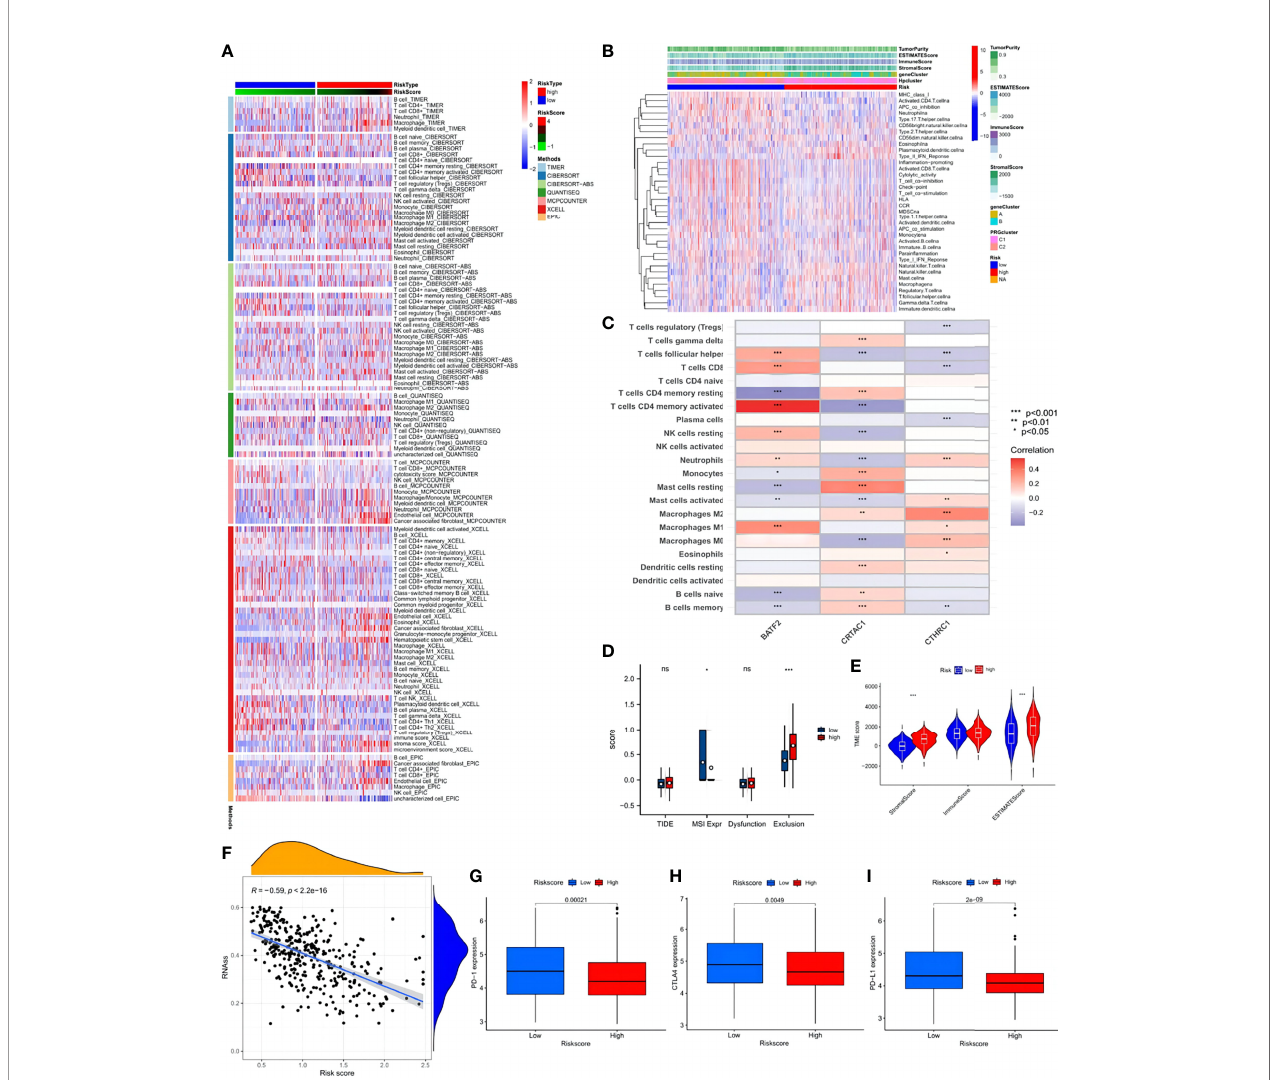
FIGURE 9 | Immune annotation and correlation between HP infection and anti-PD-1/L1, anti-CTLA-4 immunotherapy. (A) Immune cell-in fi ltrating characteristics of high- and low-risk groups and their correlation with risk signature. (B) Relations between tumor purity, ESTIMATE score, immune score, stromal score, and different STAD phenotypes. (C) Correlation between the abundance of immune cells and three candidate genes. (D) Box plot suggesting the difference of response towards immunotherapy between high- and low-risk score group. (E) Violin plot illustrating the result of ESTIMATE analysis. (F) Relationships between the risk signature and cancer stem cell (CSC) index. (G – I) Expression of PD-1, CTLA-4, PD-L1 in low- and high-risk score groups, respectively. ns, no signi fi cance, p ≥ 0.05; *, p< 0.05; **, p<0.01; ***,